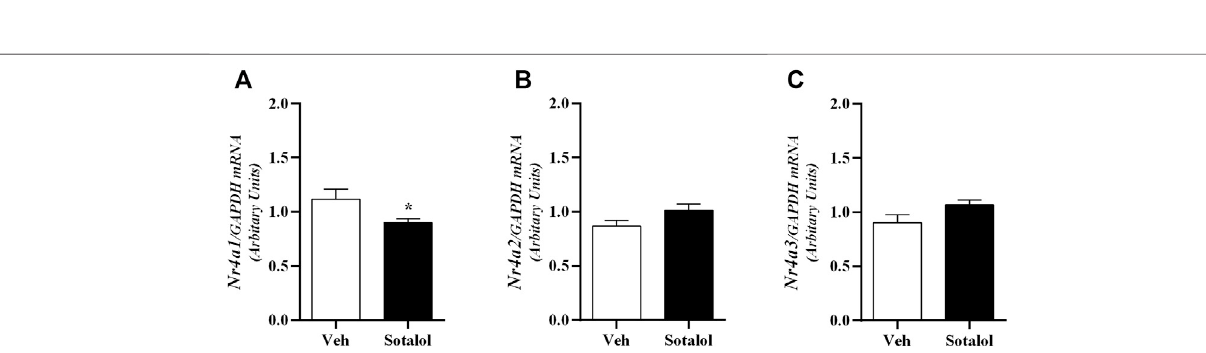
Frontiers in Pharmacology |